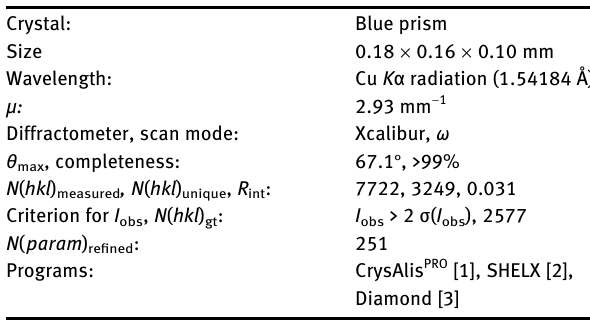
Table 1 contains crystallographic data and Table 2 contains the list of the atoms including atomic coordinates and displacement parameters.